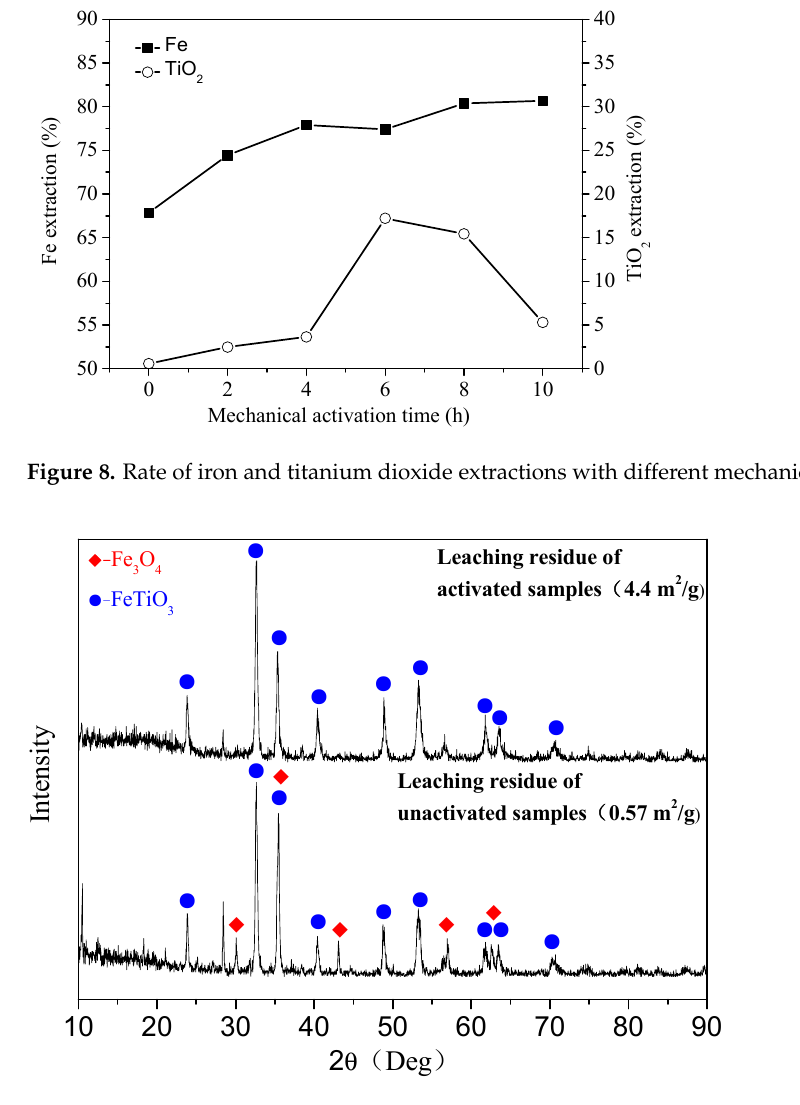
Figure 9. XRD patterns of the leaching residues for unactivated and mechanically activated samples.